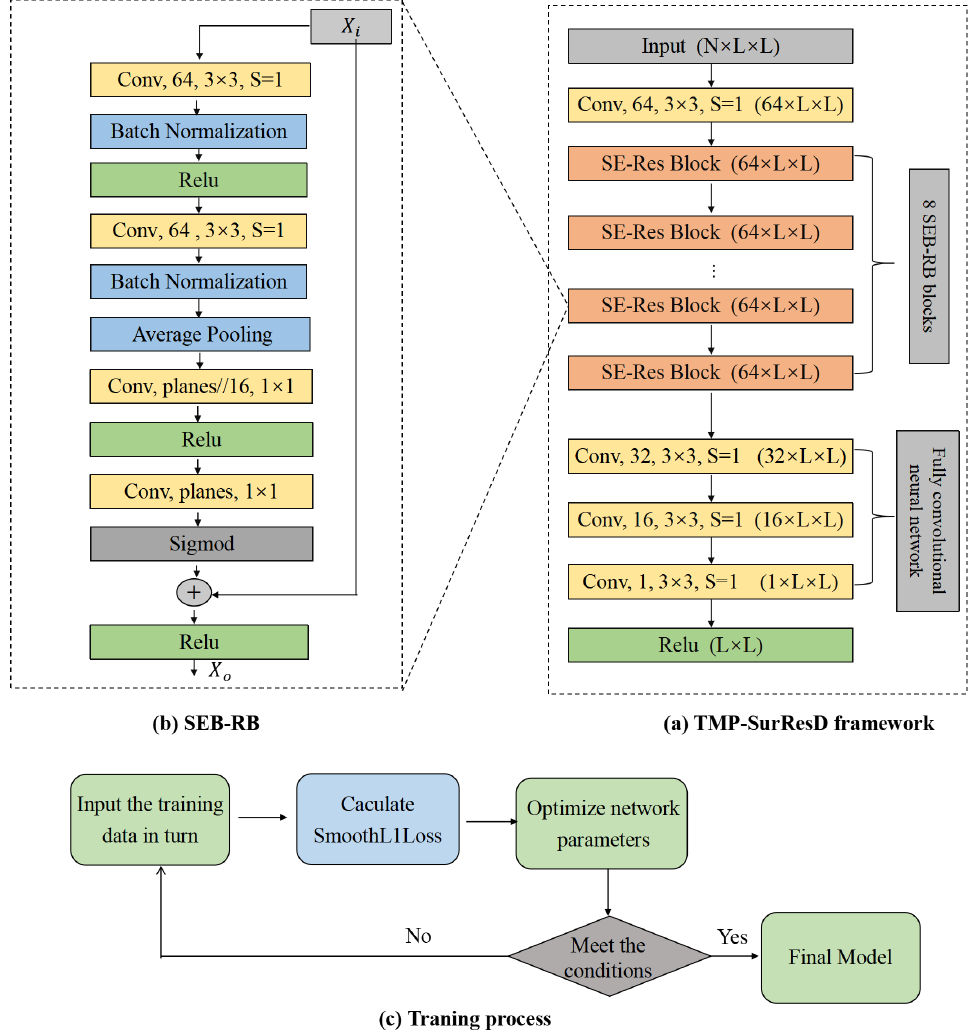
Figure 2. Details of the TMP-SurResD framework. ( a ) The network used by TMP-SurResD. The fea- ture vectors are L × L × N propagated through 12 SEB-RB blocks and a fully convolutional neural network. In the last output, the matrix of L × L corresponds to the predicted distance between all surface residues; ( b ) Basic block (SEB-RB) used in the network. ( c ) Model training